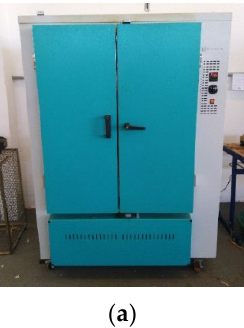
Figure 3. Panels’ heat treatment: ( a ) oven, ( b ) arrangement of panels inside the oven and ( c ) panels after heat treatment.